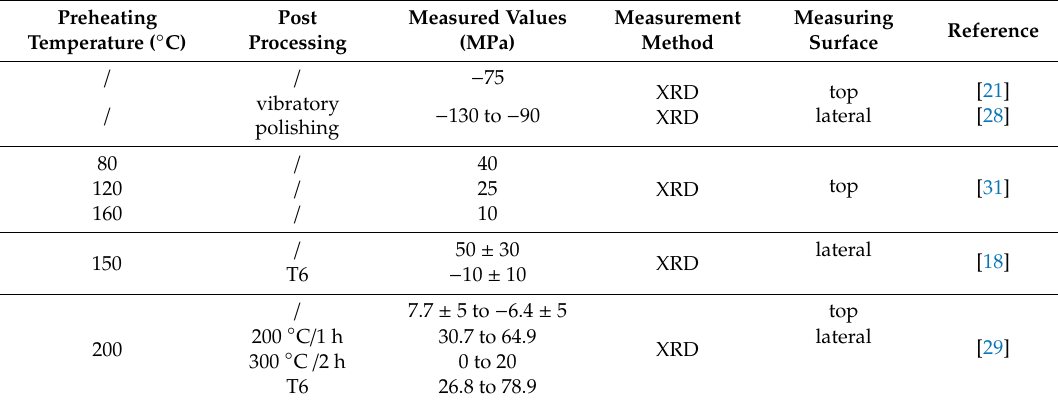
Table1. Summaryofresidualstressmeasurementsperformedonselectivelasermelting(SLM)-produced AlSi10Mg samples reported in the